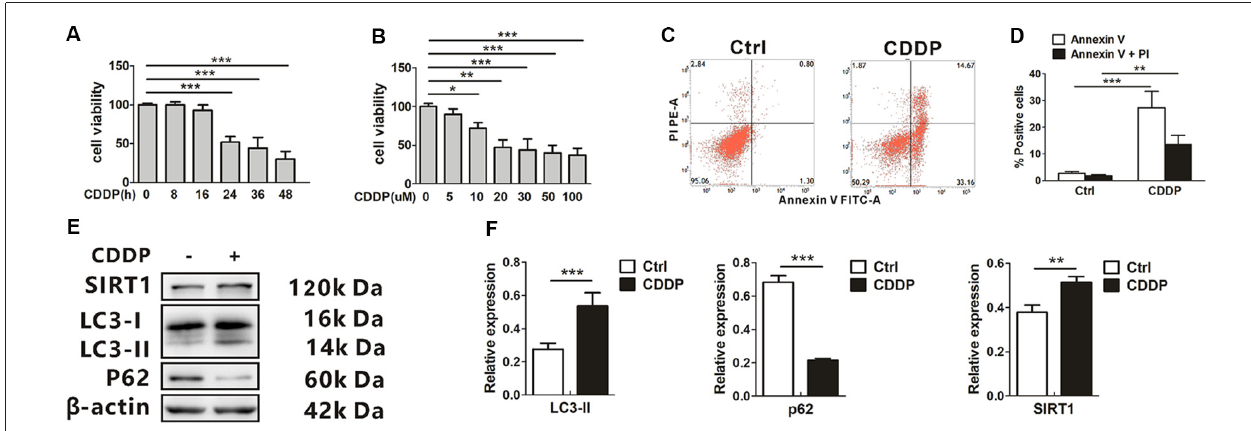
FIGURE 1 | CDDP induces cell death and increases both sirtuin 1 (SIRT1) and autophagy in HEI-OC1 cells. (A) The CCK8 assay was performed to examine cell viability of HEI-OC1 cells in CDDP (20 µ M) exposure from 0 h to 48 h ( n = 3 individual experiments). (B) The CCK8 assay was performed to examine cell viability of HEI-OC1 cells in CDDP exposure from 0 µ M to 100 µ M for 24 h ( n = 3 individual experiments). (C,D) Apoptosis measured by annexin V and propidium iodide (PI) staining for HEI-OC1 cells in CDDP (20 µ M) exposure for 24 h ( n = 3 individual experiments) and its analysis. (E,F) Western blots and densitometry analysis for SIRT1 and autophagy marker LC3-II and p62 in CDDP (20 µ M) exposure for 24 h ( n = 3 individual experiments). Data represent the mean ± SEM. ∗ p < 0.05, ∗∗ p < 0.01, ∗∗∗ p < 0.001. CDDP, cisplatin.